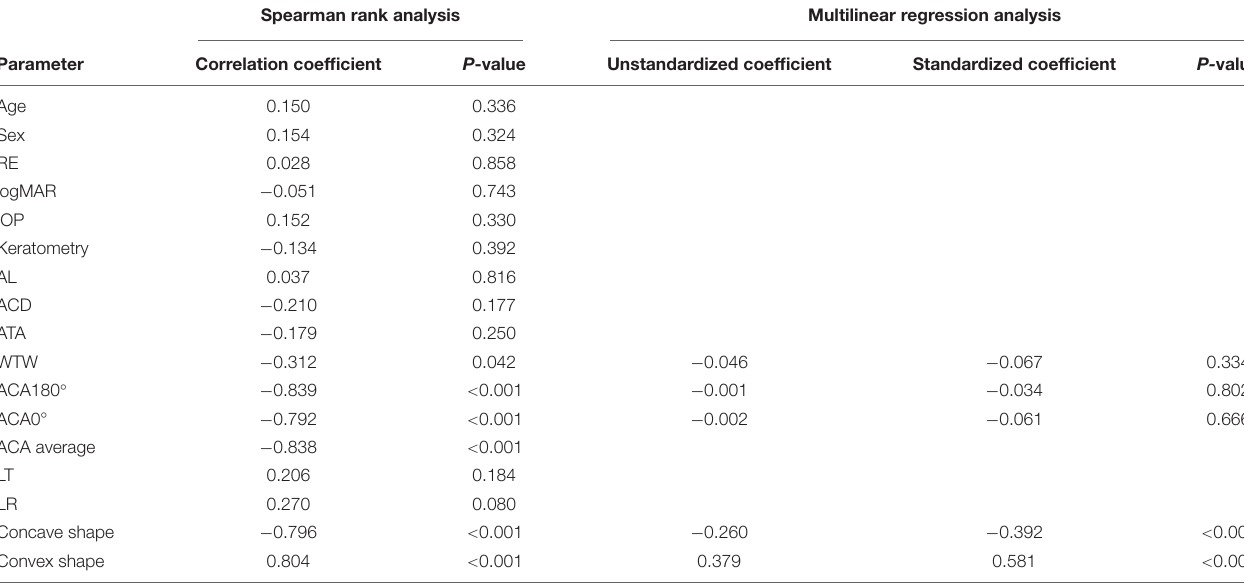
TABLE 2 | Results of spearman correlation analysis and multilinear regression analysis evaluating the association between preoperative biometric parameters and central vaulting after ICL